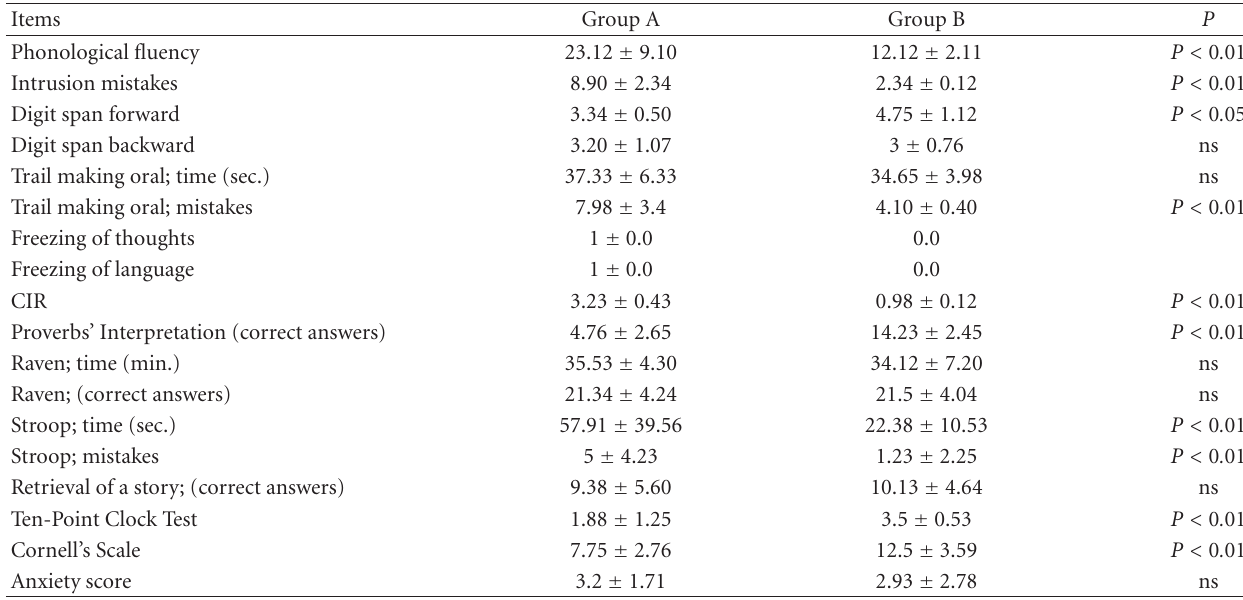
Table 3: A comparison between the two groups, at baseline.